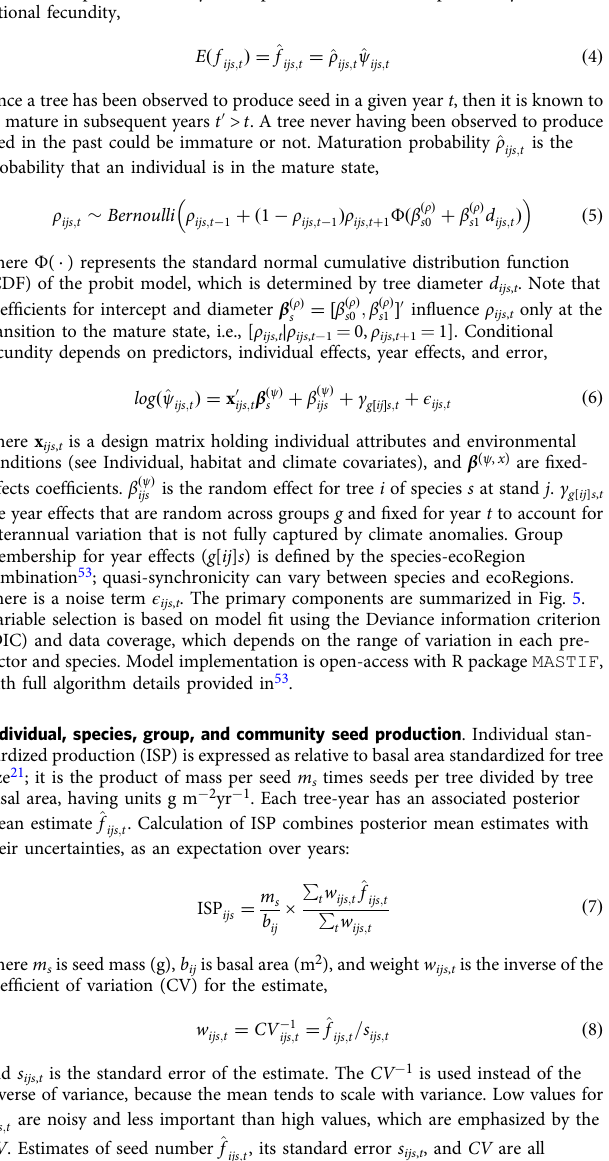
calibration to sites having local weather data.